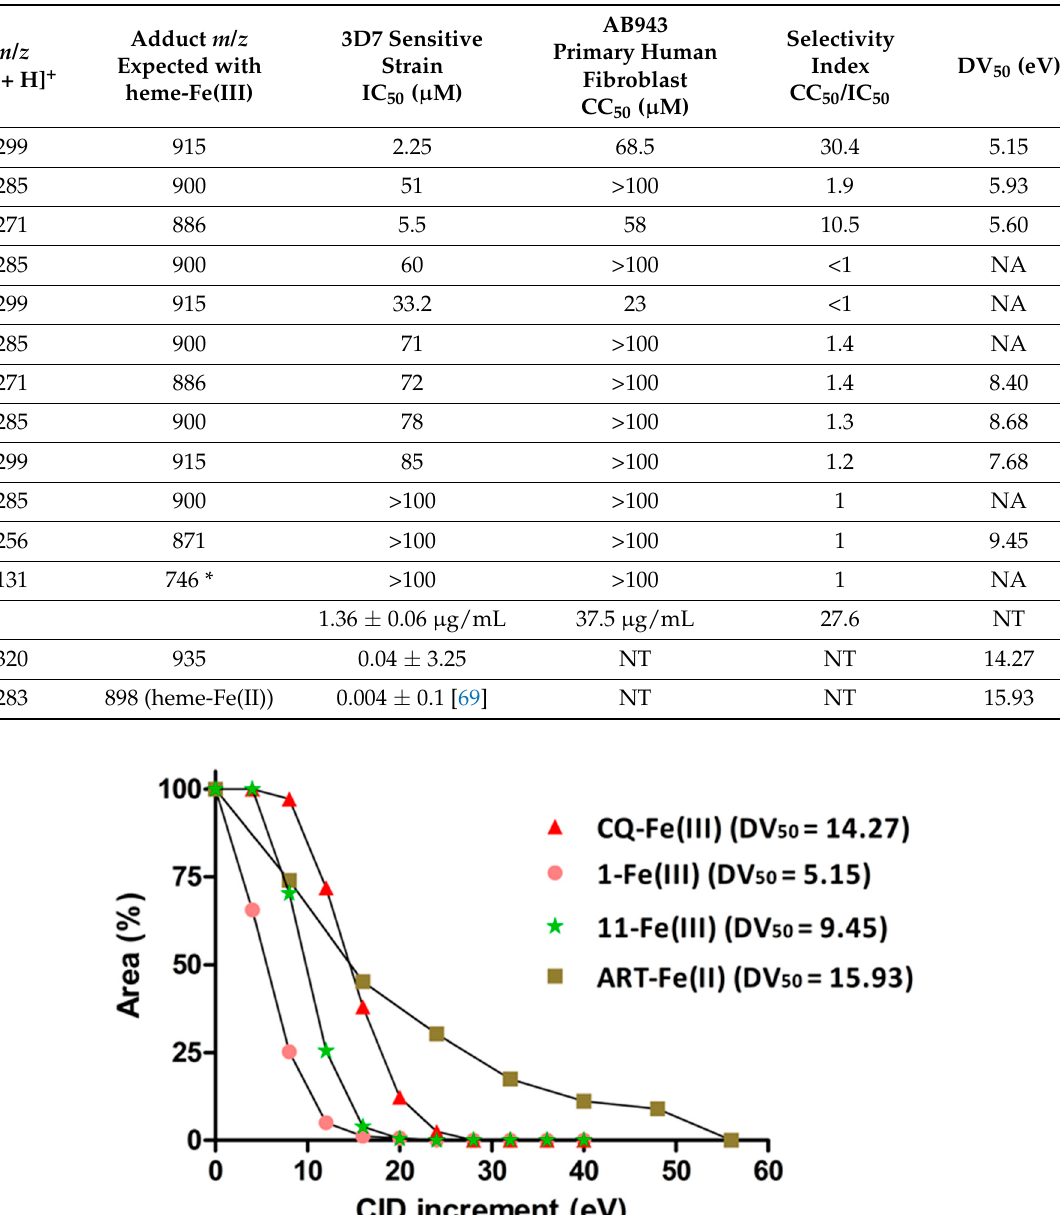
Table 2. Antiplasmodial activity, cytotoxicity, and dissociation voltage of isolated compounds. NT = not tested; NA = no adduct; CQ = Chloroquine; ART = Artemisinin. * Adduct not detected. Cpd = compounds. Selectivity index was calculated with CC 50 on AB943 Primary human fibroblast line cells and IC 50 for antiplasmodial activity.